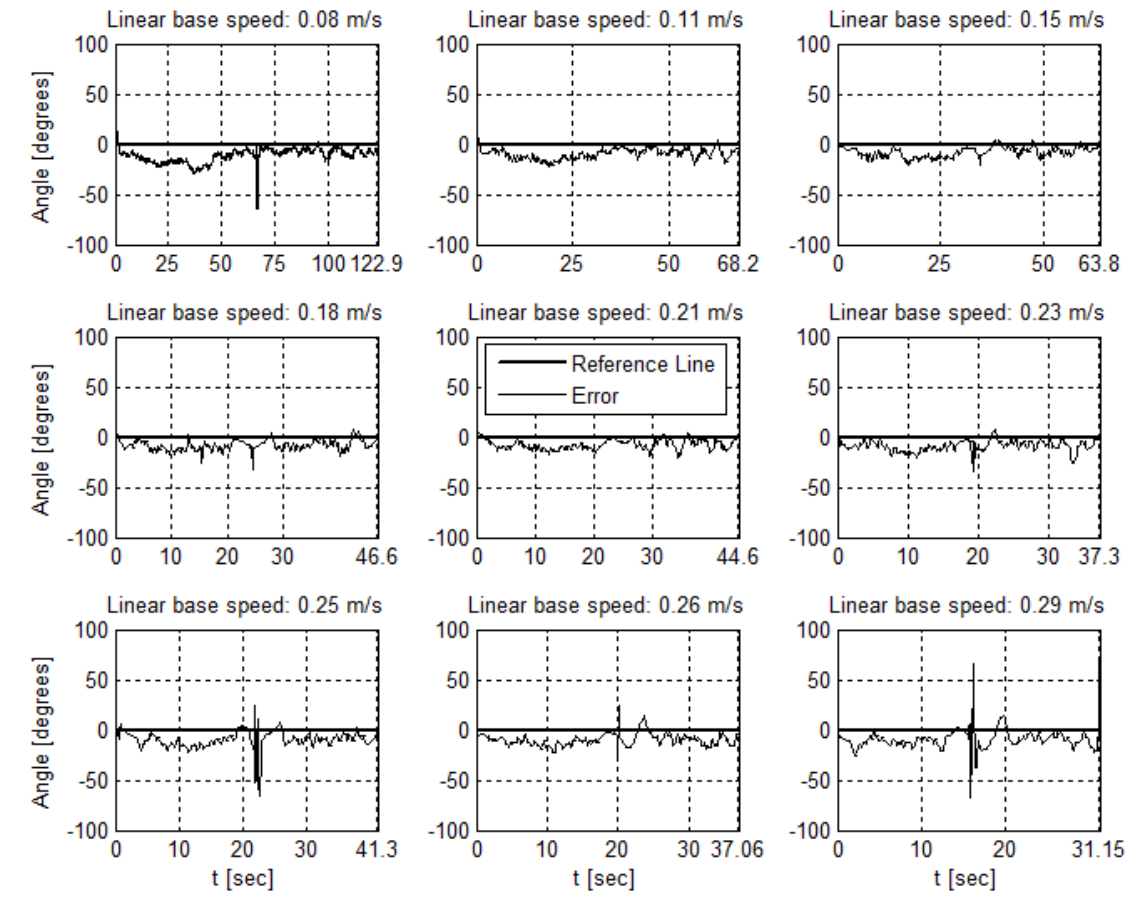
Figure 27. A cycle of angle measurements at each AGV linear base